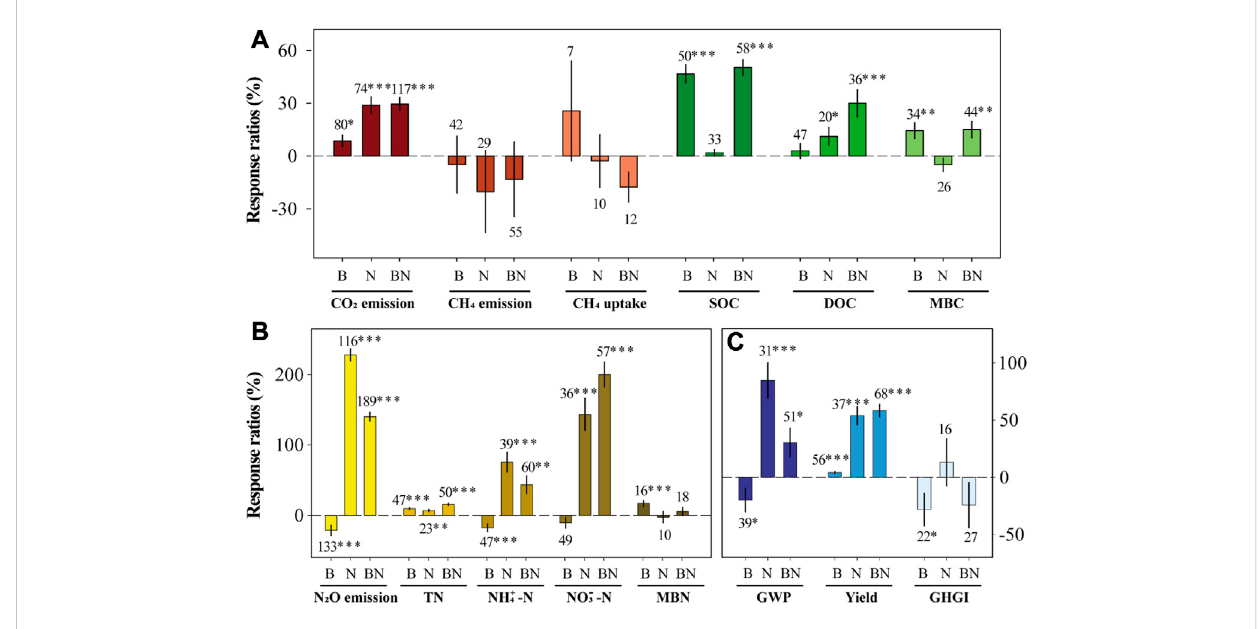
FIGURE 1 Effects of biochar, nitrogen (N), and combined biochar and N (BN) additions on soil carbon cycle (A) , N cycle (B) and GHGI (C)